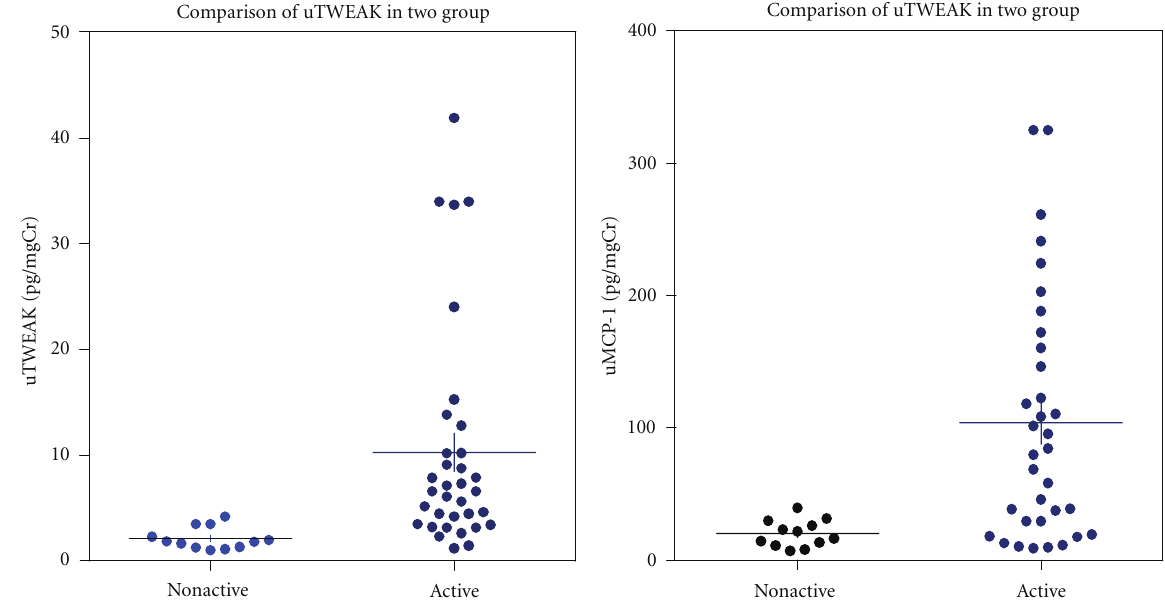
Figure 2: uTWEAK and uMCP-1 correlate with LN activity. A comparison of uTWEAK and uMCP-1 between 34 cases and 12 nonactive cases. Patients with active renal disease had significantly higher urinary TWEAK levels and higher urinary MCP-1 levels. Bars indicate median values.